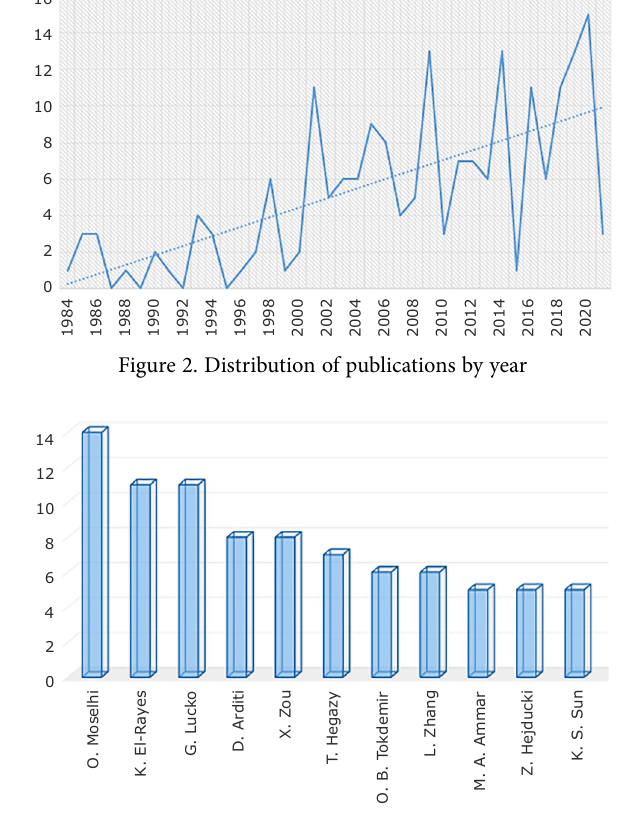
Figure 3. Distribution of publications by author